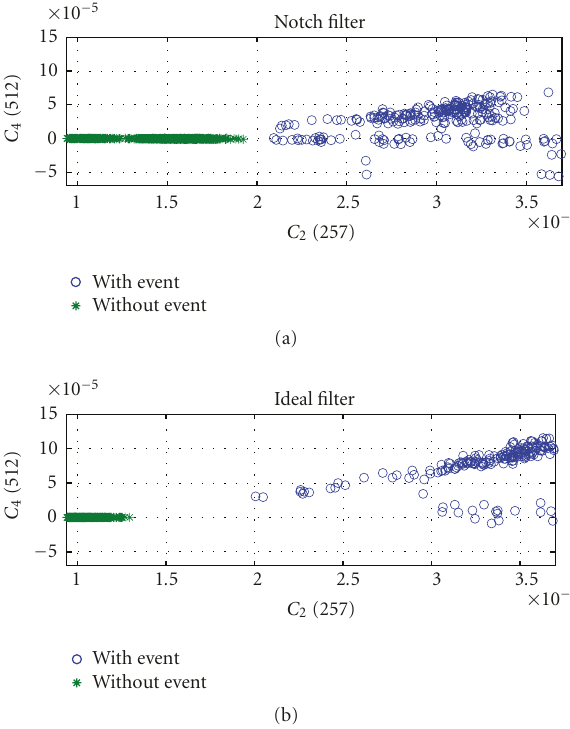
Figure 3: HOS-based features extracted from voltage signals whose frame length is equal to N = 256. For this frame length, second- and fourth-order statistics are extracted from u .